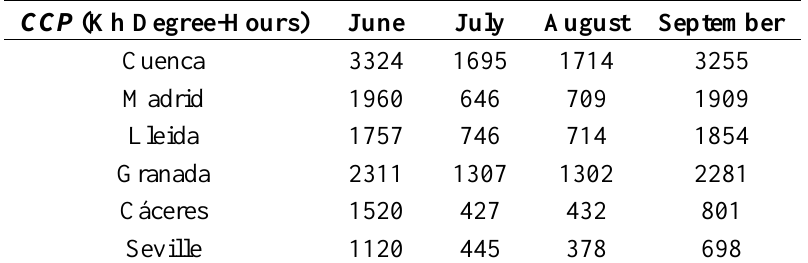
Table 4. Climate cooling potential ( CCP ) values for selected climates.